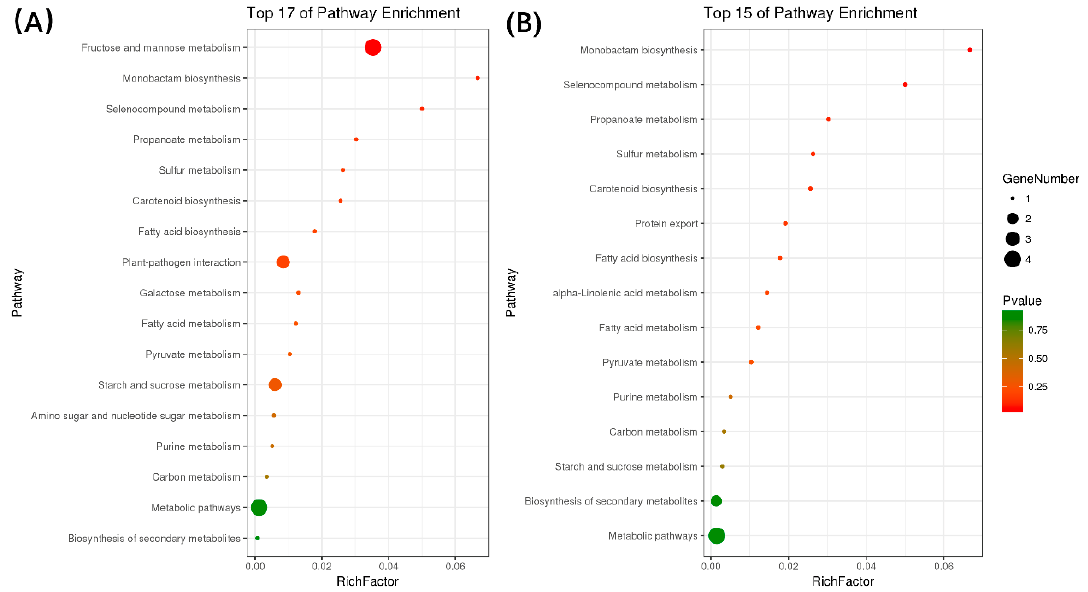
Figure 6. The bubble graph of salt/alkali response miRNA targets analysis in the KEGG (kyoto encyclopedia of genes and genomes). ( A ) Top 17 pathways enriched by miRNA responsive targets in salt stress; ( B ) Top 15 pathways enriched by miRNA responsive targets in alkali stress.